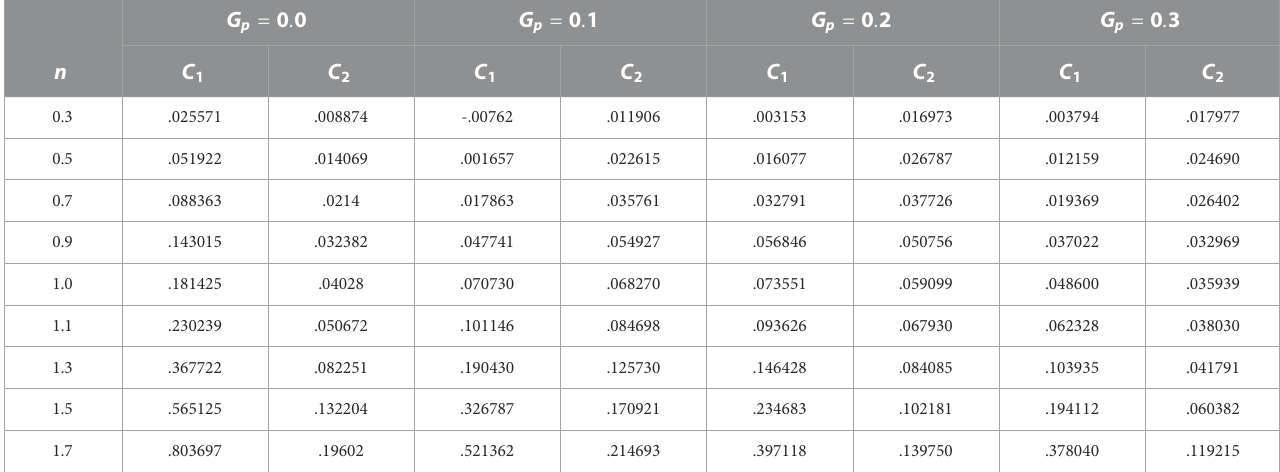
TABLE 5 In fl uence of the lift coef fi cient of both cylinders against n with various gap spacing.